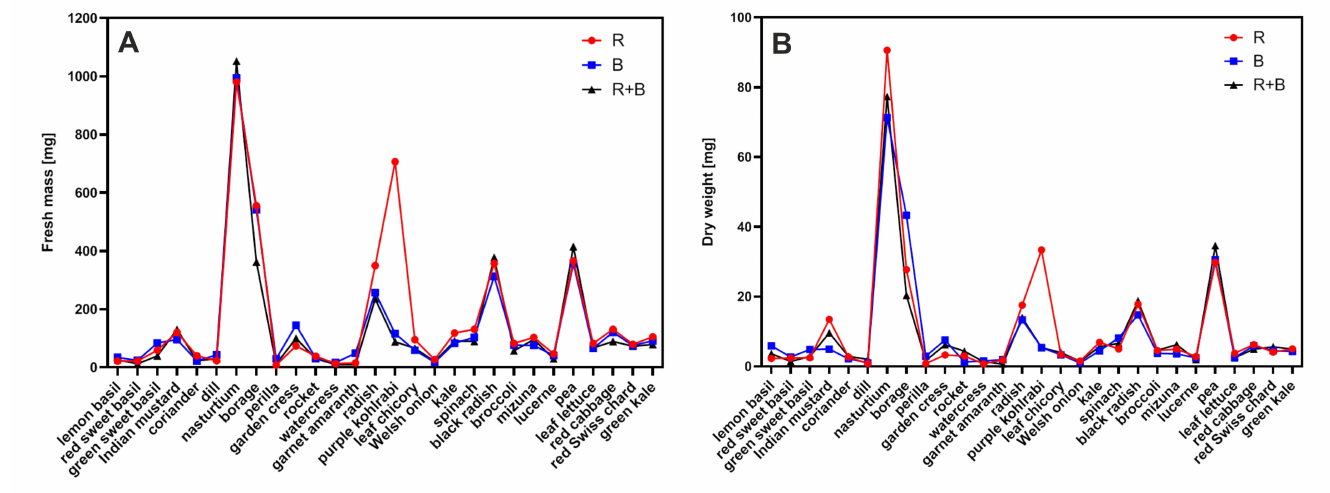
Figure 2. The fresh ( A ) and dry weight ( B ) [mg] for 28 microgreen crops depending on light combina- tions. The Red:Blue ratio for each combination–R light 6.7; B light 0.6; R + B light 1.6.